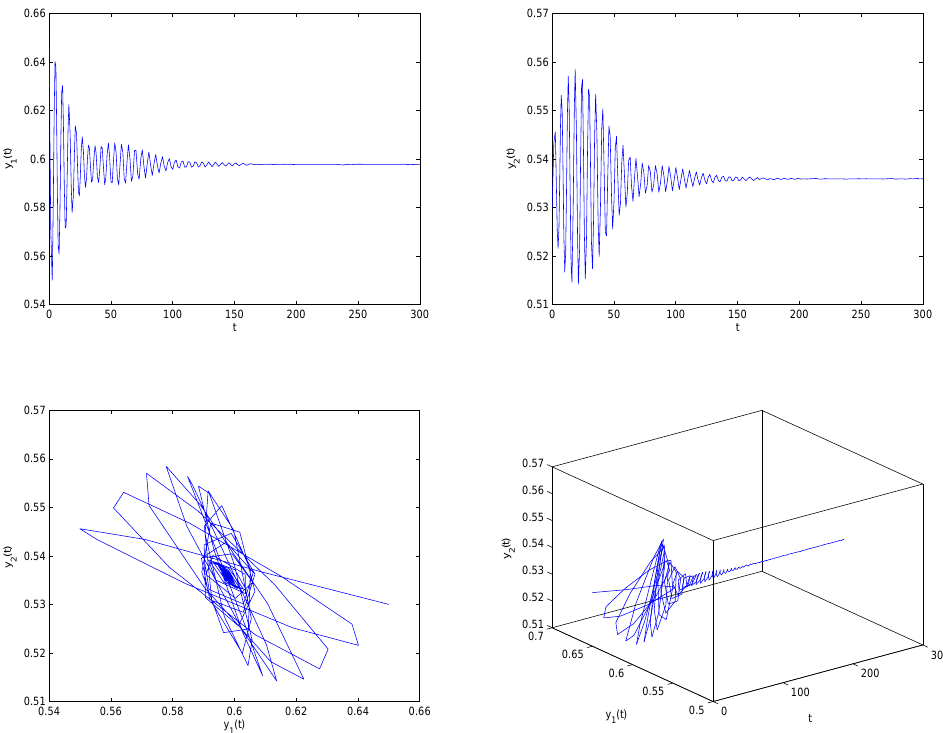
= 1.33. The positive ∗ = 1 . 33 . The positive ∗